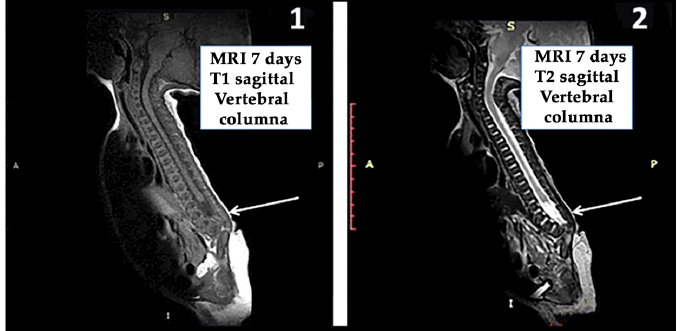
Figure 4. Magnetic resonance imaging (MRI) of the vertebral column MRI performed at 7-days of age. ( 1 ) The white arrow shows that the vertebral column development had been interrupted at the L2–L3 level and that the spinal cord was tethered; ( 2 ) A small lipoma can be seen at the end of the conus medullaris (arrow); there was sacral agenesis too. A: anterior; P: posterior; S: superior; I: Inferior. T1, the time when 63% of the longitudinal magnetization has recovered; T2, the time when 63% of the transverse magnetization has decayed.